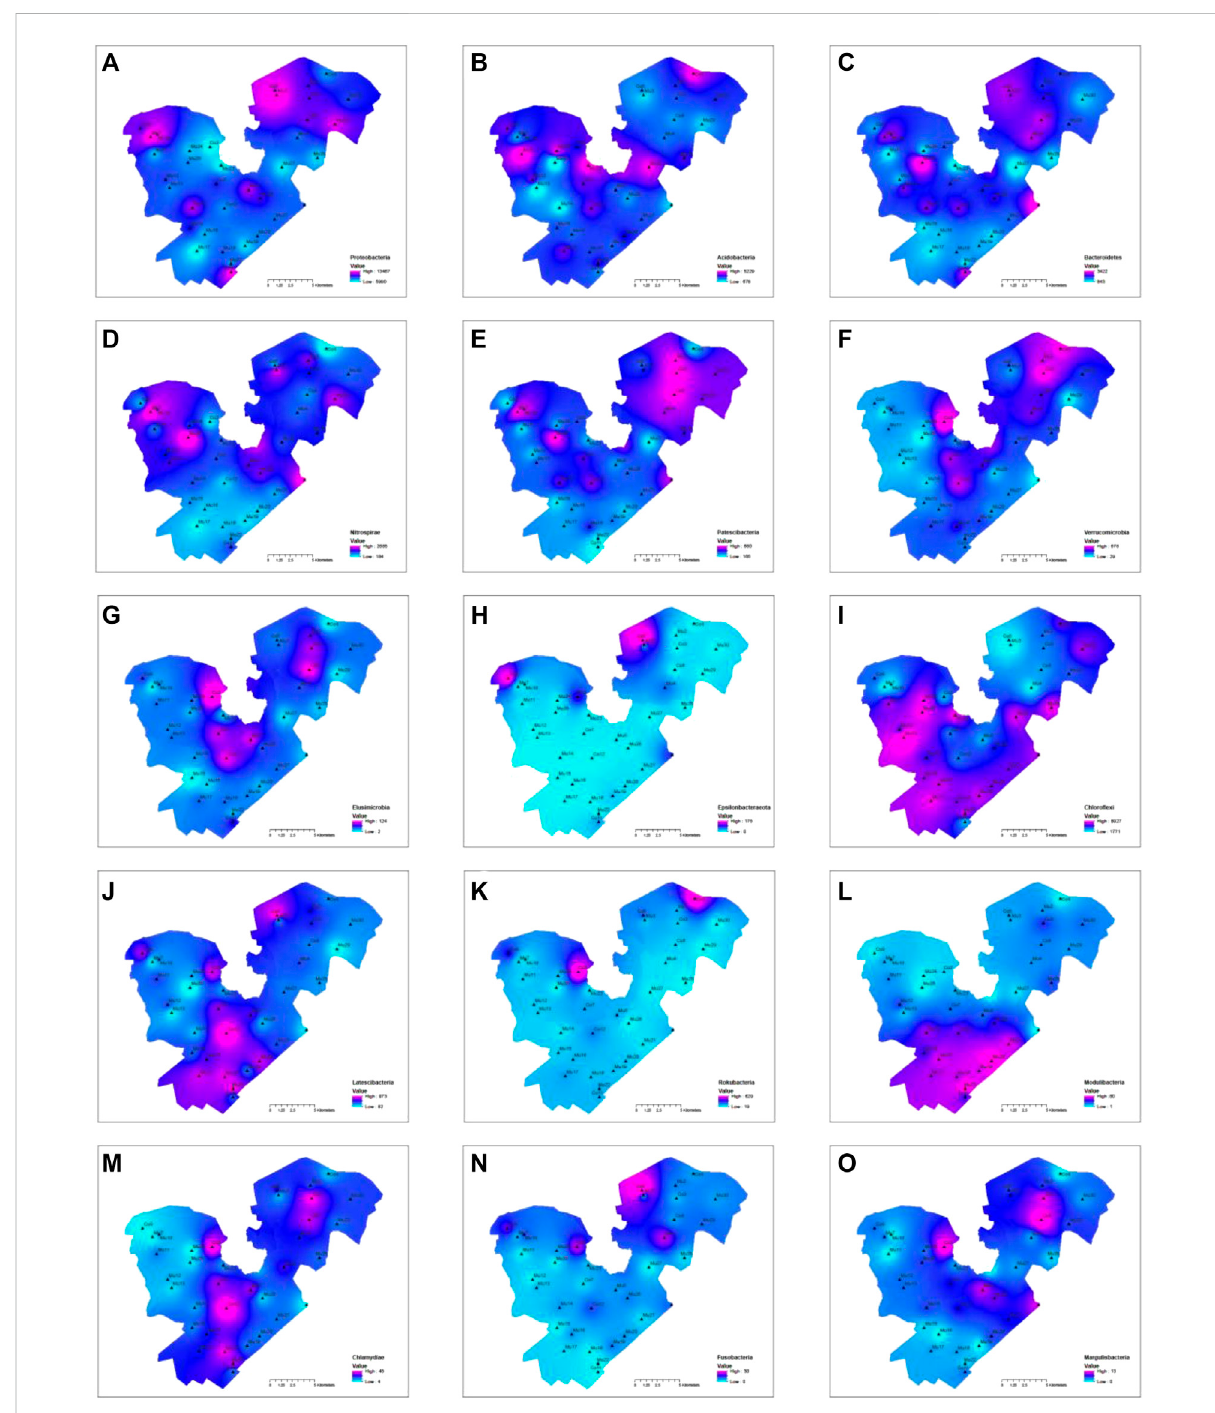
FIGURE 8 Contours of top ten most abundant phyla and fi ve other phyla, in which the absolute abundance was used for the contouring: (A) Proteobacteria, (B) Acidobacteria, (C) Patescibacteria, (D) Bacteroidetes, (E) Nitrospirae, (F) Latescibacteria, (G) Verrucomicrobia, (H)